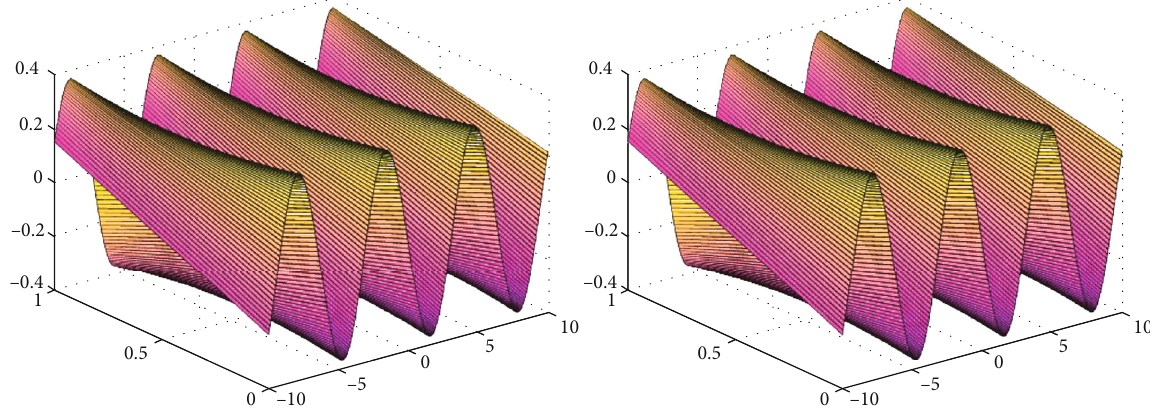
Figure 5: Graph of exact and analytical results of Problem